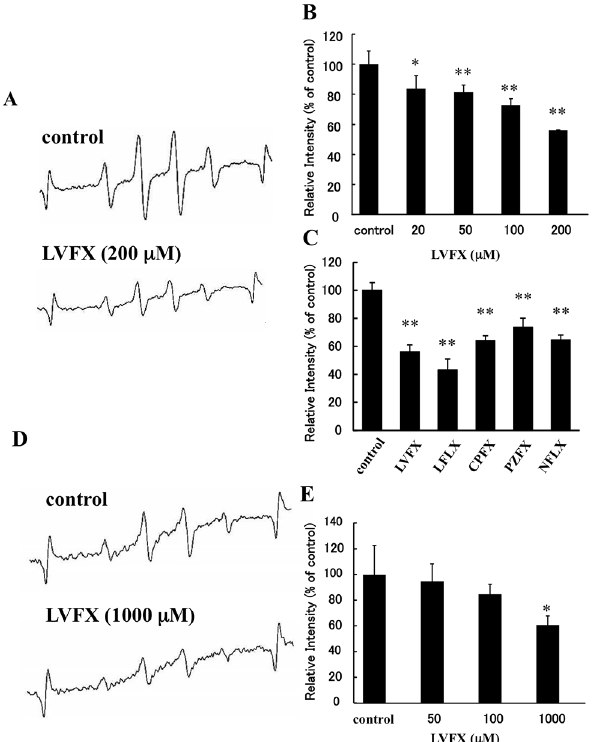
Fig 1. Measurement of anti-oxidative effects of LVFX using EPR spectroscopy. The scavenging activities of LVFX against ROS derived from the UV/H 2 O 2 system or neutrophils stimulated with 100 ng/ml PMA were determined using ESR spin trapping with DMPO. (A) The reaction mixtures, which contained 500 μ M H 2 O 2 , 100 μ M DTPA and 4.5 mM DMPO, were incubated with each FQ and were immediately transferred to an ESR flat cell and irradiated at 254 nm for 30 s. After UV-irradiation, the ESR flat cells immediately placed in a JES-TE 200 ESR spectrometer. ESR spectrum of DMPO spin adducts of OH radicals and (B) the quantitation of the OH radicals concentration were shown. (C) The scavenging activity of 200 μ M FQs; lomefloxacin (LFLX), levofloxacin (LVFX), Ciprofloxacin (CPFX), pazfloxacin (PZFX), and norfloxacin (NRFX) against OH radicals. (D) ESR spectrum of DMPO spin adducts ROS derived from neutrophils containing OH radicals, and (E) the quantitation of the ROS concentration were shown. Each bar represents the mean ± SD (n = 3). * p < 0.05, ** p < 0.01 vs